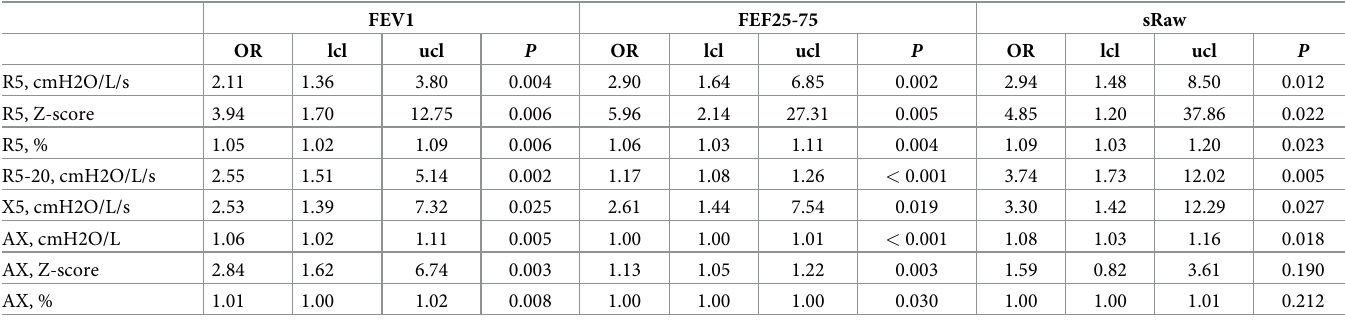
Table 3. Multivariate logistic regression for PFT parameters with IOS. FEV1 FEF25-75 sRaw OR